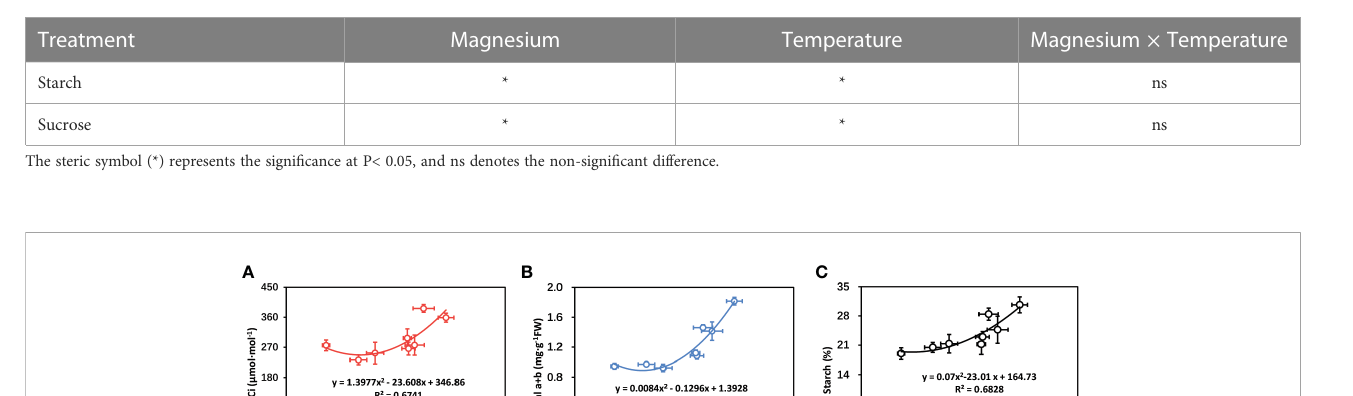
(abs), and PSII functional activity index based on standardized ABS absorption, and the lower the cold stress, the greater the decline (Figure 8D). Mg application signi fi cantly inhibited the decrease in PI (abs). Cold stress signi fi cantly decreased the DF (abs), and PSII driving force based on standardized ABS absorption.